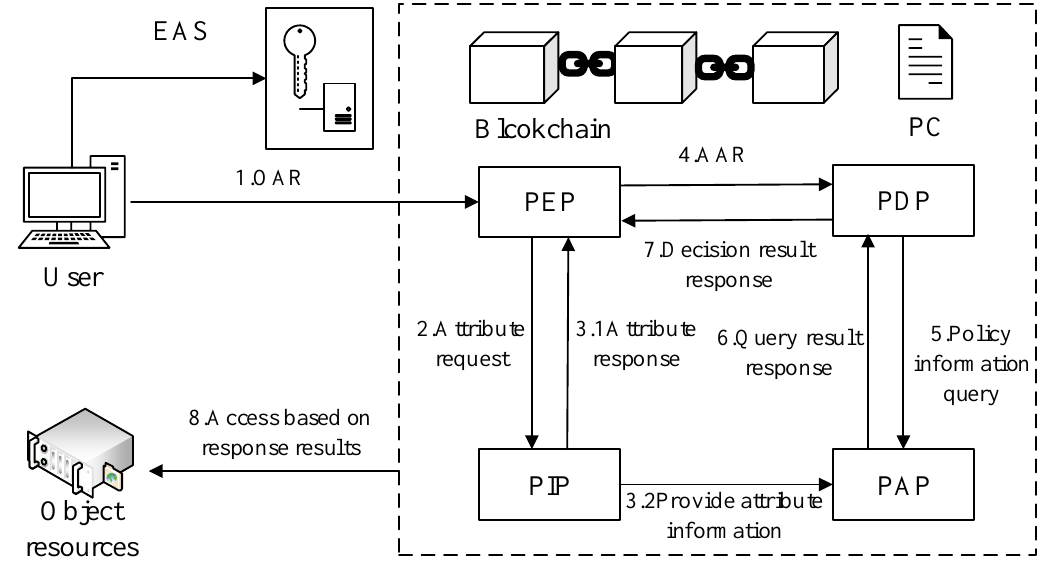
Figure 2. System model.